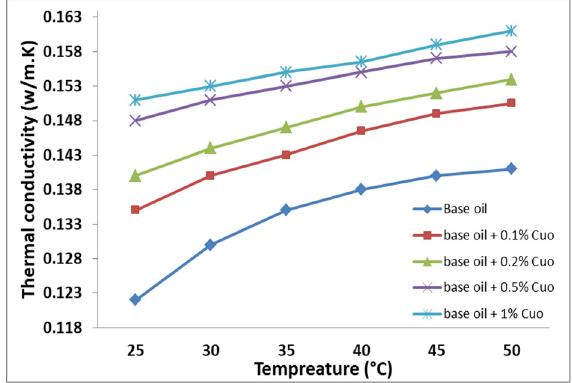
Fig. 7. Comparison of the thermal Conductivity between the parent oil and nano-lubricants at different temperatures and concentration.